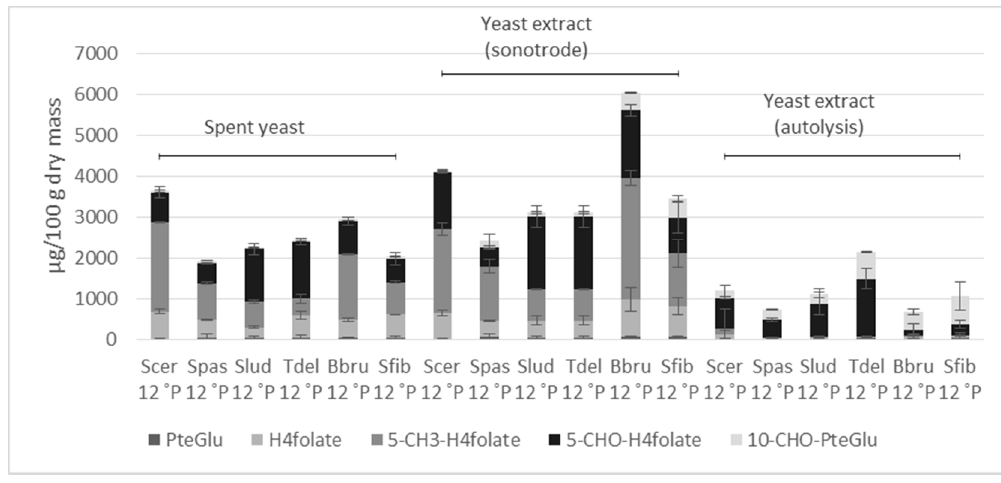
Figure 7. Distribution of the folate vitamers 5-CH 3 -H 4 folate, 5-CHO-H 4 folate, 10-CHOPteGlu, H 4 folate and PteGlu in spent yeast, yeast extracts (via sonotrode or autolysis) ; influence of yeast strain (Scer, Spas, Slud, Tdel, Bbru, Sfib); for results of the pairwise t-test, see text; data are expressed as mean values ± confidence limits .